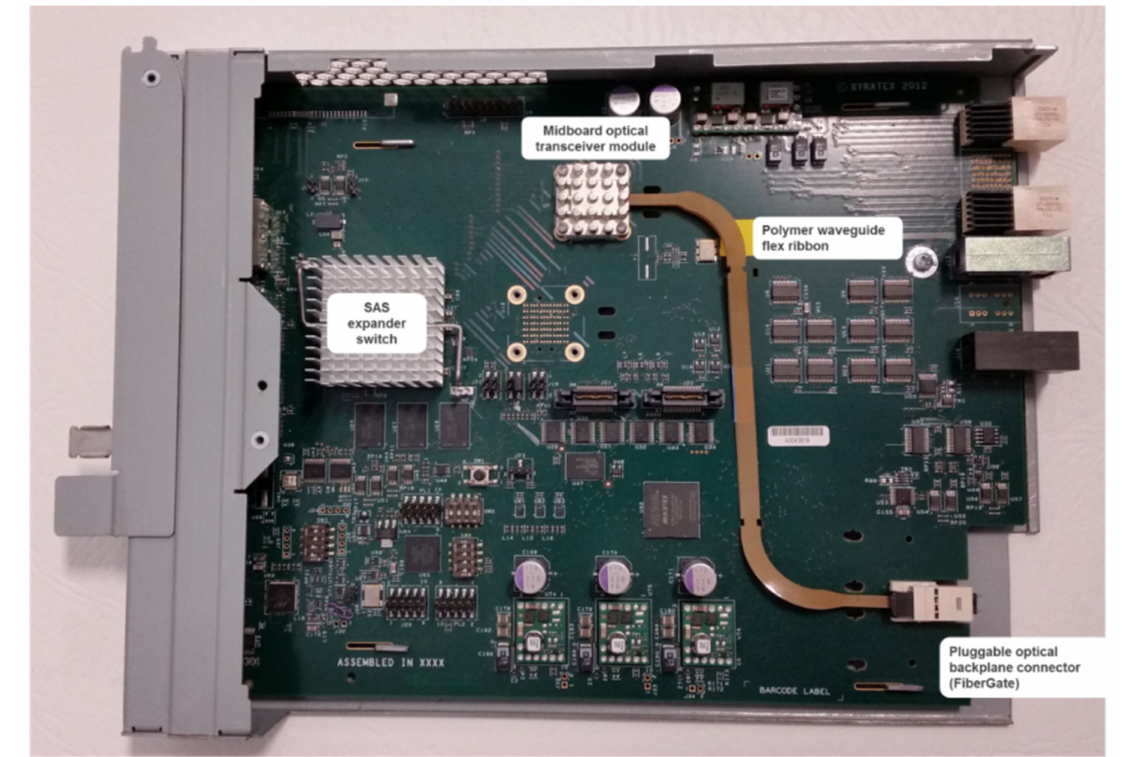
Figure 5. LightningValley optically enabled data storage switch controller daughtercards with polymer waveguide flexible ribbon and Huber + Suhner FiberGate optical backplane